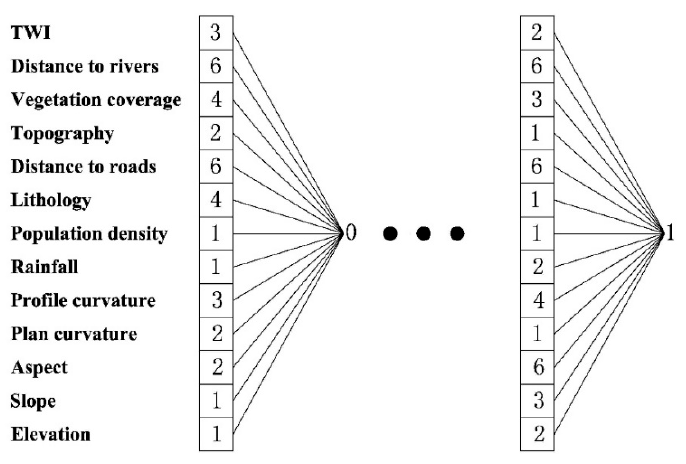
Figure 3. The one–dimensional corresponding relationship between thirteen influencing factor values and whether a debris flow occurs.